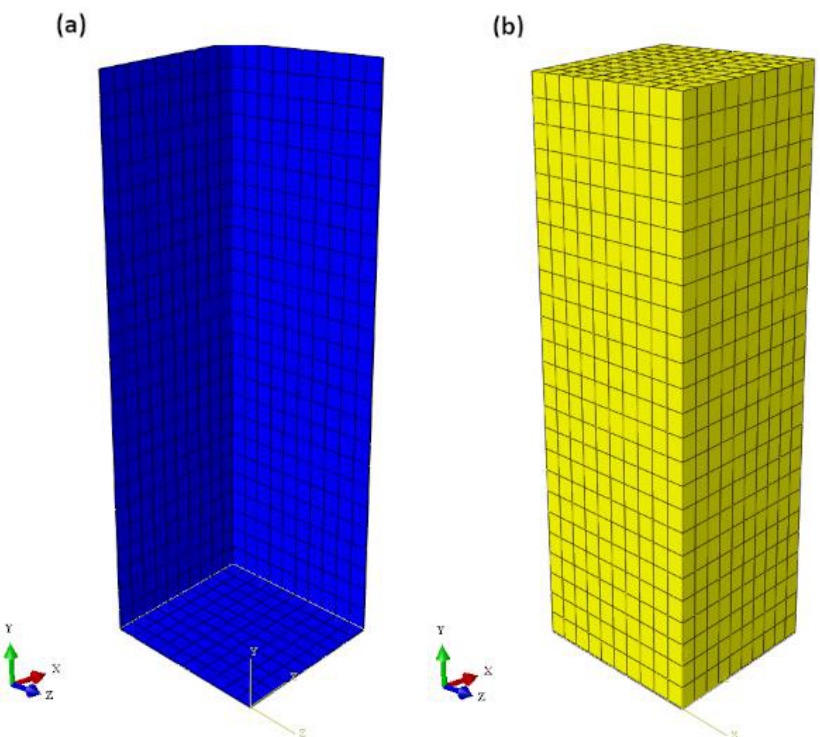
Figure 4. Abaqus model of a quarter of the silo. ( a ) Silo walls and base elements t wall/base = 6 mm. (Steel); ( b ) granular materials elements (Leighton Buzzard sand).